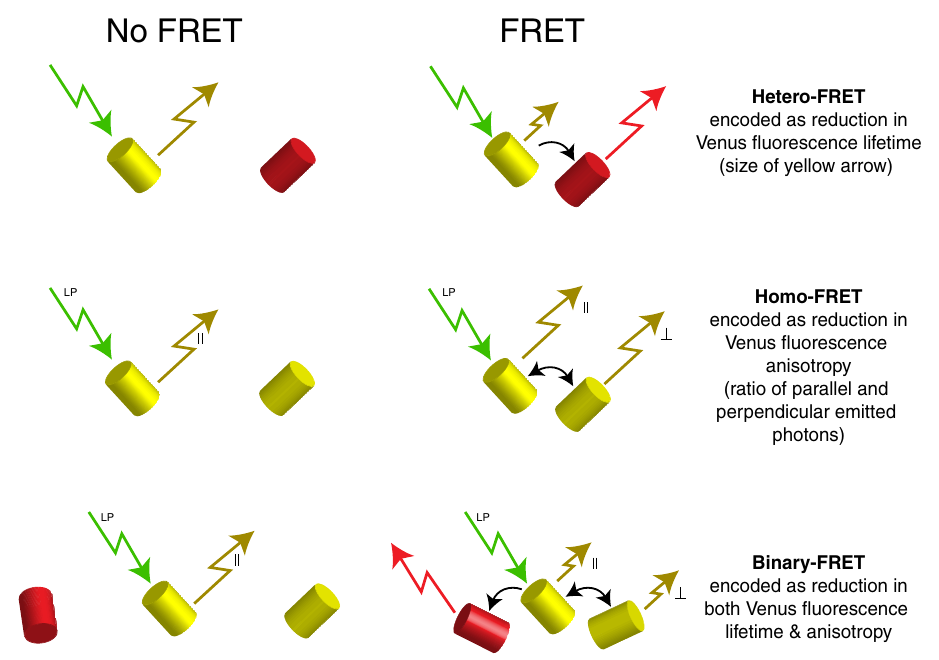
Fig. 1 | The theoretical basis for binary-FRET: hetero-FRET and homo-FRET multiplexing. The hetero-FRET donor lifetime change is indicated by the size of